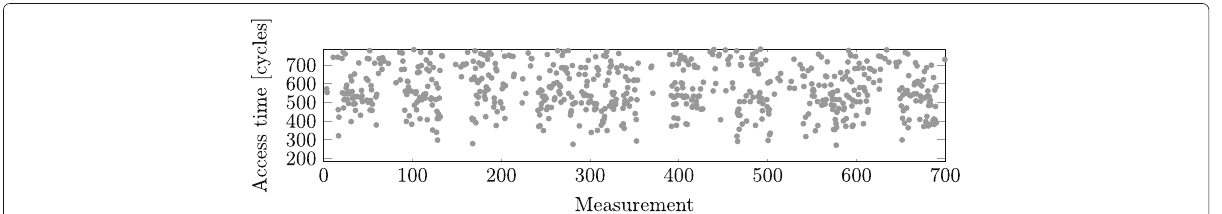
Fig. 6 Dense areas indicate a high cache-hit rate, white areas are intervals with cache misses